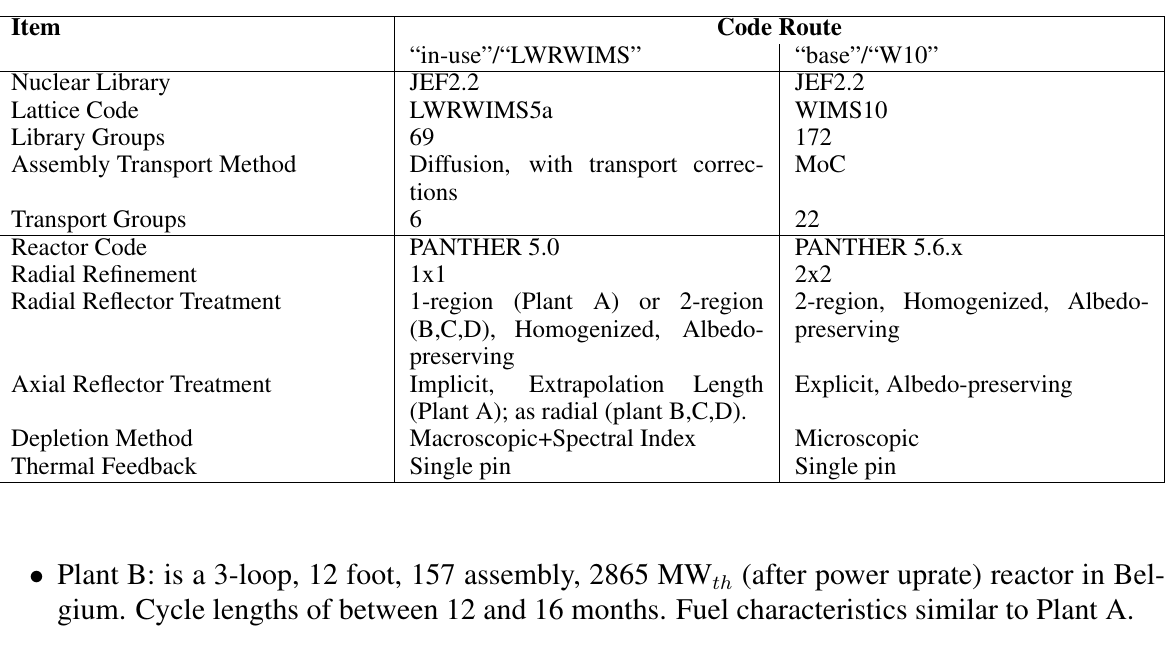
Table I: Comparison of WIMS/PANTHER Models